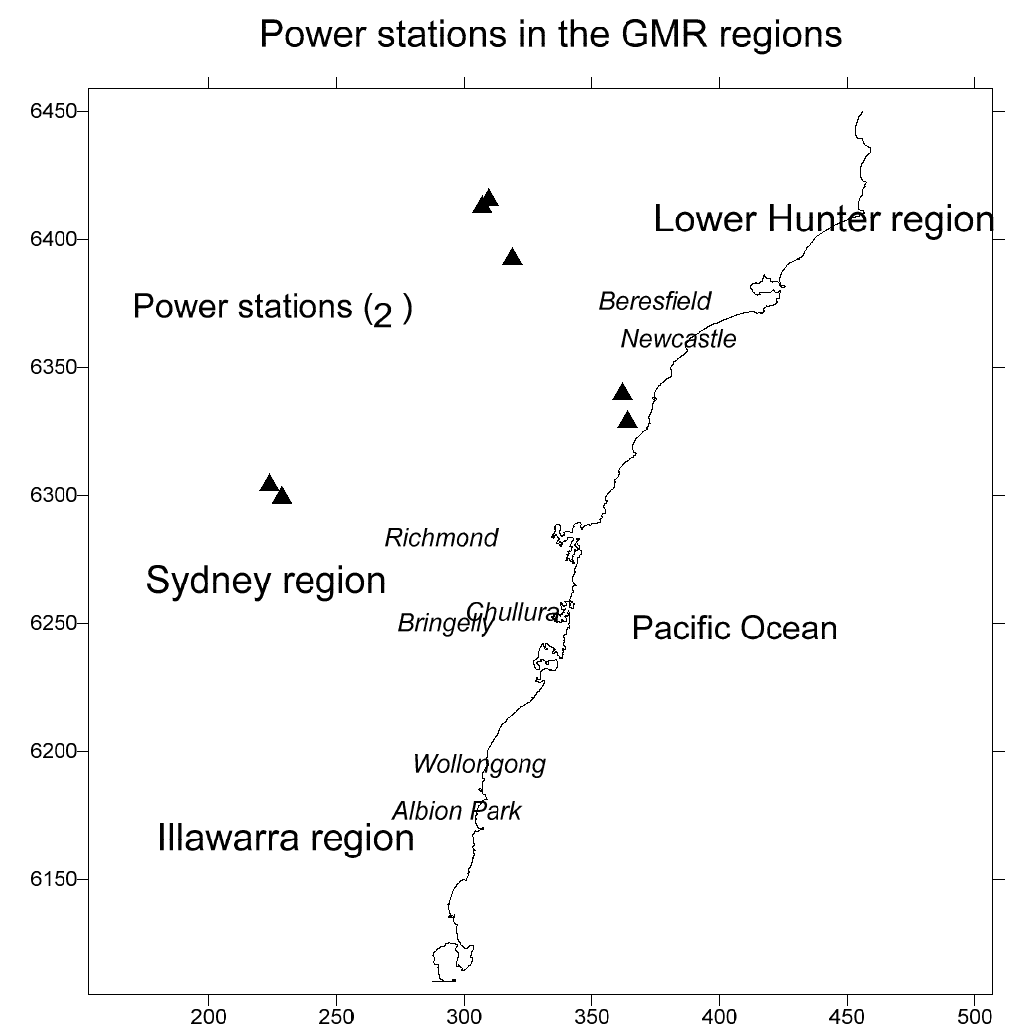
Figure 3. Non-road area source NO weekend emission ( above ) for October 2008 (unit in kg/day) and locations of power stations in the GMR ( bottom ).